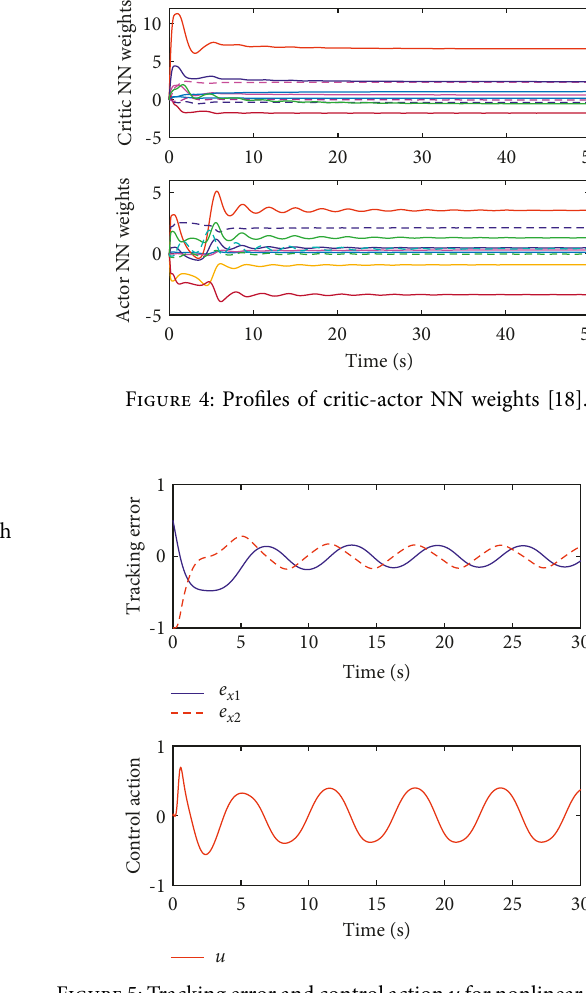
Figure 5: Tracking error and control action u for nonlinear systems [18].